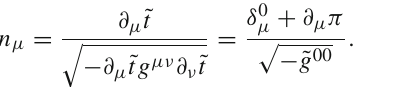
Fig. 2 The constrained phase space of (cid:9) G 2 XX and (26), (28) together with the Minkowski bound G 2 XX ≥ 0. The black dashed line is given by Eq. (26). The curved lines are given by Eq. (28). It can be seen that as cosmological evolution becomes important (i.e: ( H /(cid:2)) 2 gets larger), the phase space becomes more constrained for non-zero G 3 X .Constraintlineswith ( H /(cid:2)) 2 > 0 . 1arenotplottedsince assumptions used to derive the bound break down when the scattering energy scale is comparable to the Hubble scale, hence the gray region in the